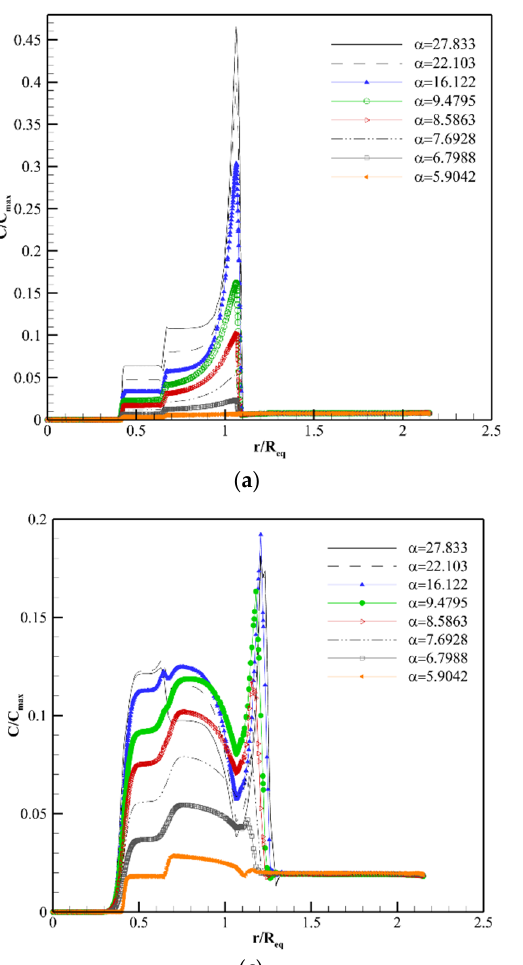
Figure 9. Distribution of ( ) F ab ′ concentration along line 1. ( a ) 1 h post-injection. ( b ) 8 h post-injec- tion. ( c ) 24 h post-injection. ( d ) 72 h post-injection.